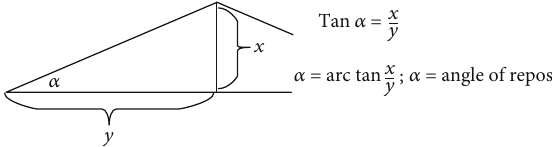
Figure 2: Static angle of